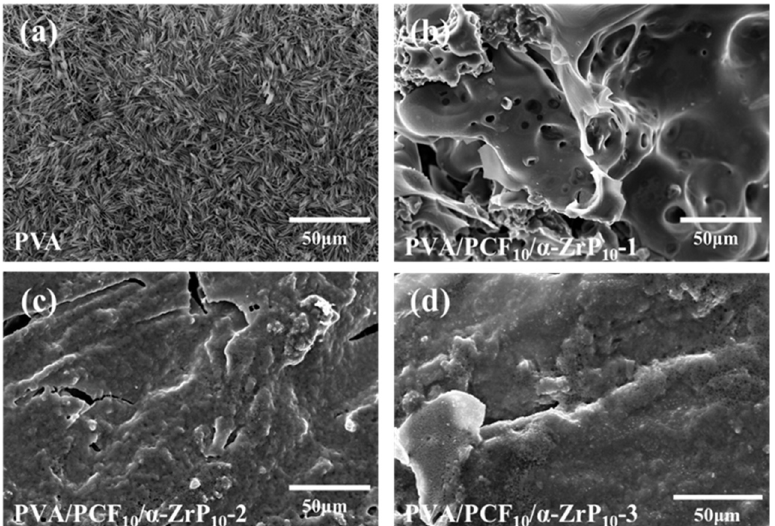
Figure 13. SEM images of the residues of ( a ) PVA, ( b ) PVA/PCF 10 / α -ZrP 10 -1, ( c ) PVA/PCF 10 / α -ZrP 10 -2, and ( d ) PVA/PCF 10 / α -ZrP 10 -3 after cone calorimetry.